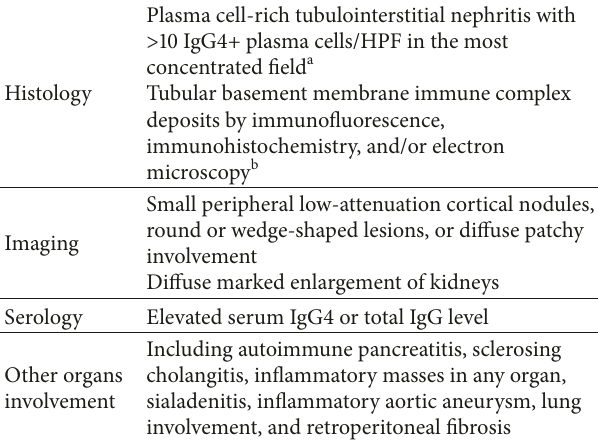
Table 2: Diagnostic criteria for IgG4-related tubulointerstitial nephritis (TIN) proposed by Raissian et al.